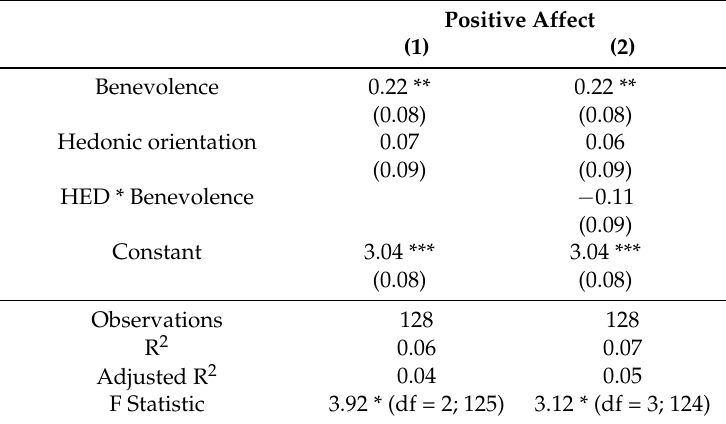
Table 4. Regression results using hedonic orientation as a